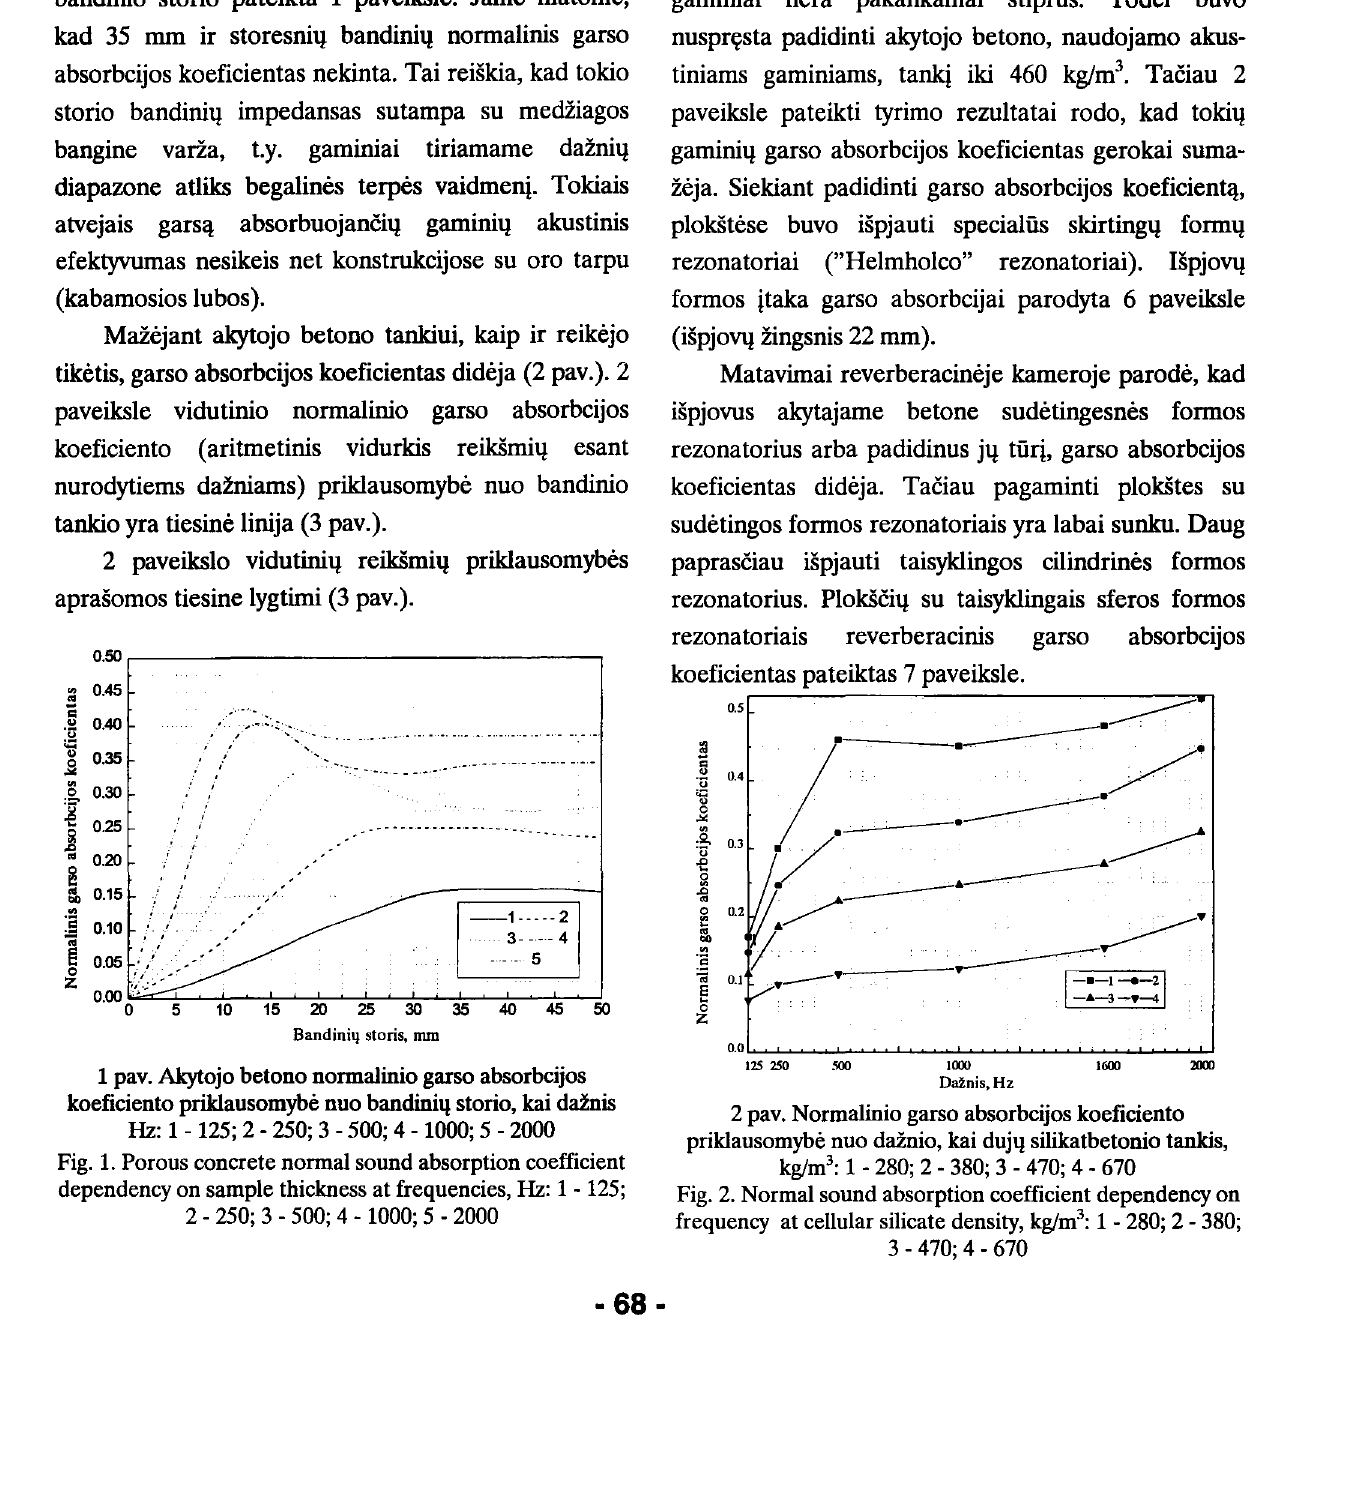
Fig. 1. Porous concrete normal sound absorption coefficient dependency on sample thickness at frequencies, Hz: 1- 125; Fig. 2. Normal sound absorption coefficient dependency on